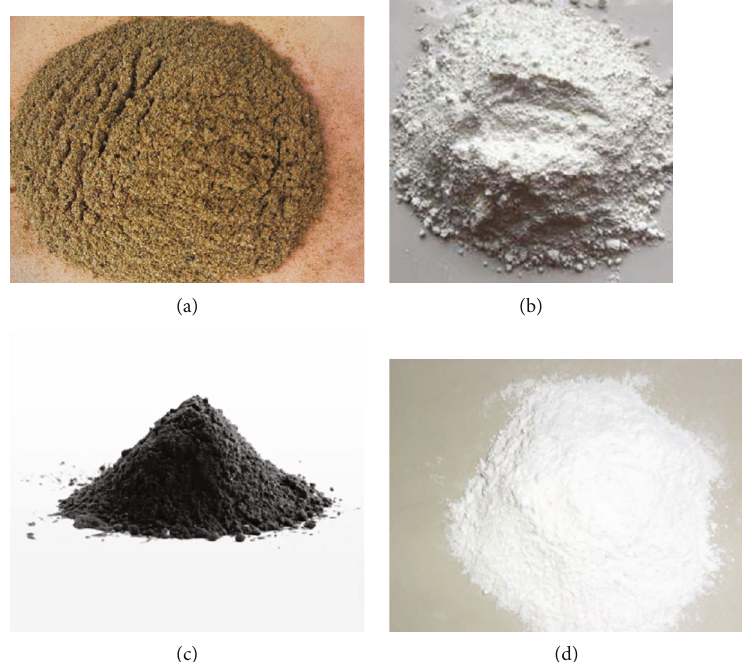
Figure 1: Raw materials of the similar material: (a) river sand, (b) barite powder, (c) cement, and (d)